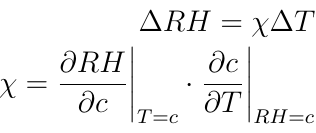
Figure 3. Derivative of relative humidity to temperature vs. temperature for relative humidity of 0–100 % . For example: at 90 ◦ C and 20 % RH , an error of 1 ◦ C in temperature induces a 2 % error in relative